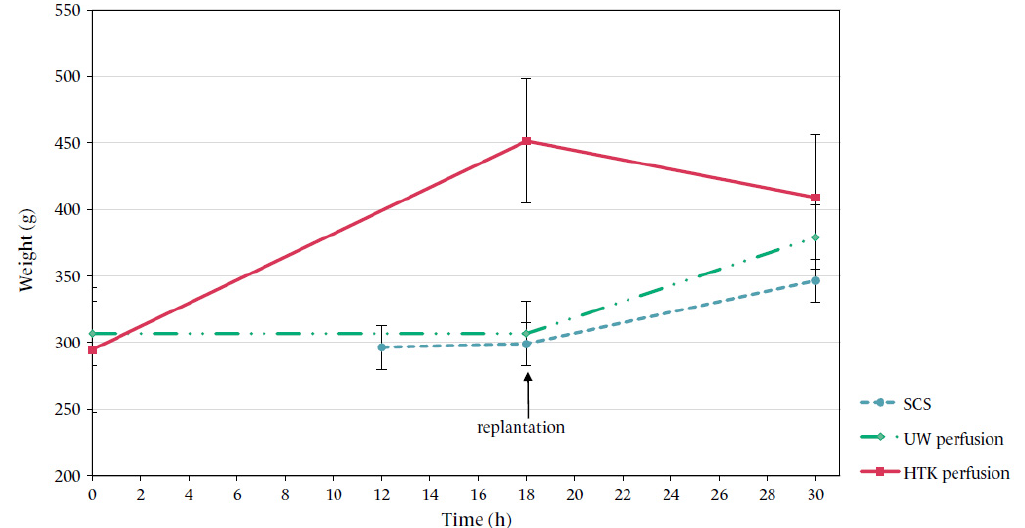
Figure 6. Mean flap weight over time per group. Time points of flap weight measurements: directly after flap retrieval, after 4 h cold storage or 18 h ECP and after 12 h